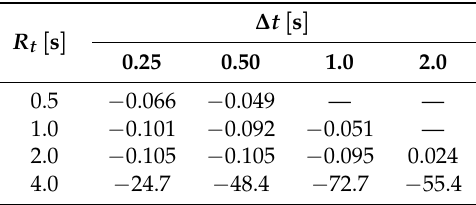
Table 4. Relative errors for ω , (cid:101) ω (in %), as a function of ∆ t and R t for ∆ x = 2 m, corresponding to linear propagation of W1.